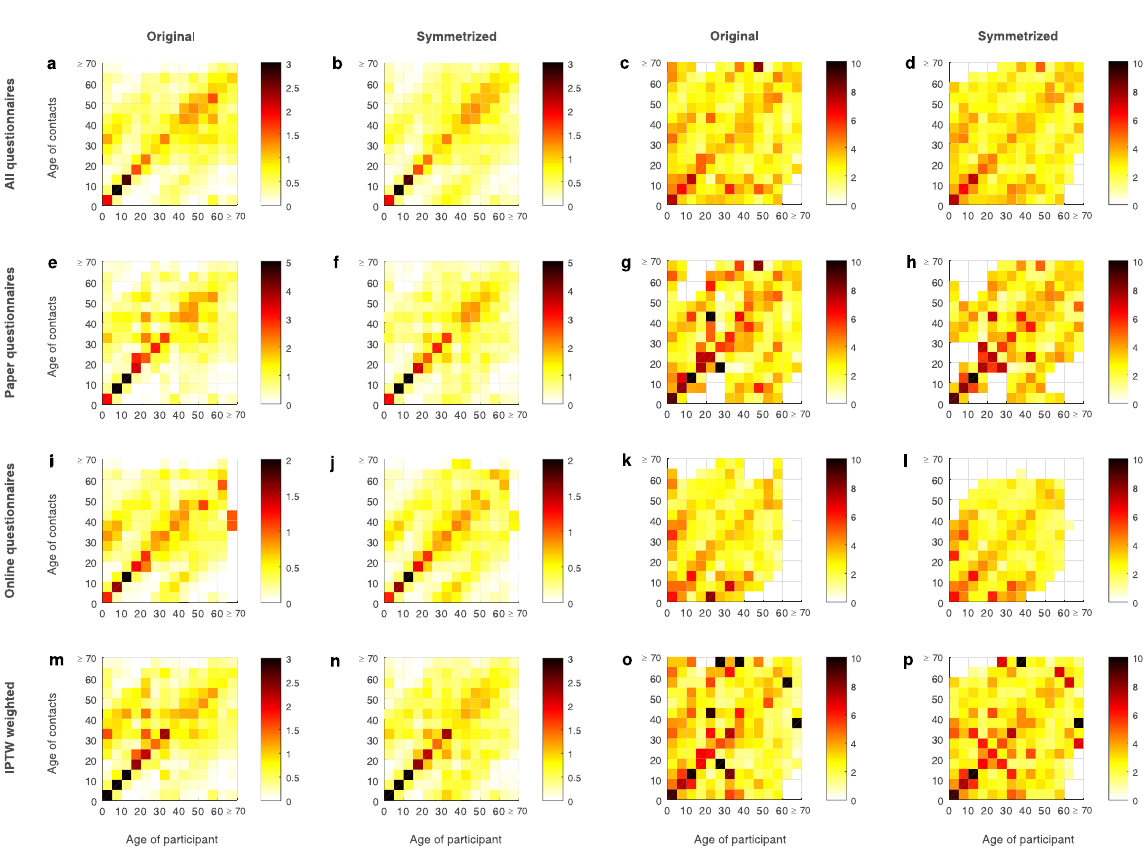
Figure 5. Contact matrix of reported contacts consisting of the average number of contacts and mean contact duration per day per participant. ( a – d ) All reported contacts; ( e – h ) Contacts reported in paper questionnaires; ( i – l ) Contacts reported in online questionnaires; ( m – p ) Reported contacts weighted by inverse probability of treatment weighting (IPTW) using propensity scores for mode of questionnaire. The original contact matrices { c ij } show the average number of contacts or mean contact person hours in age group i reported by participants from age group j ; the symmetrized contact matrices are calculated using